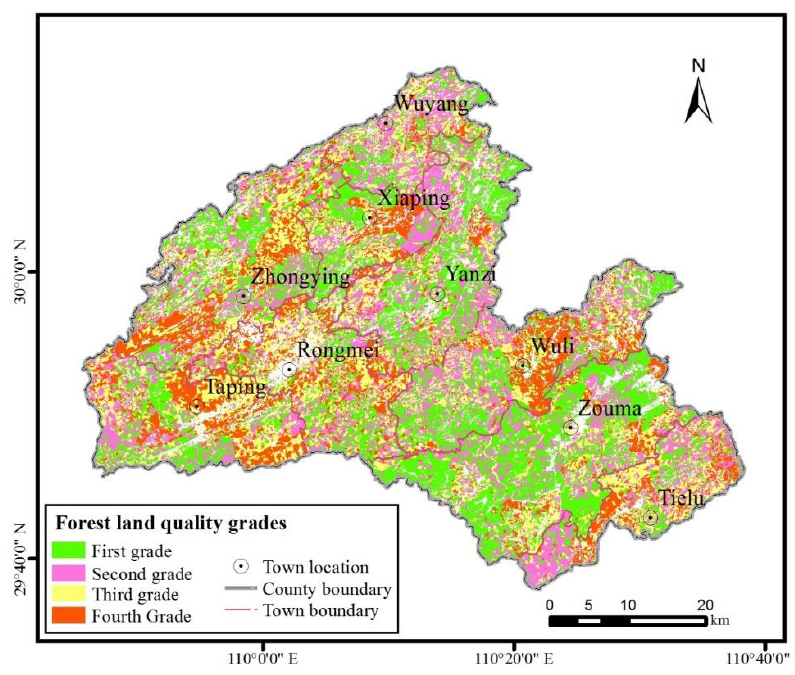
Figure 4. Spatial distribution of forest land quality grades in Hefeng.